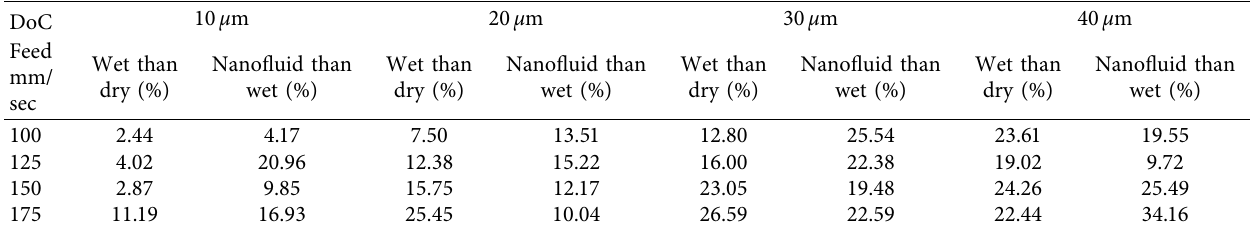
Table 11: Surface roughness reduction by coolant and lubricant at a constant depth of